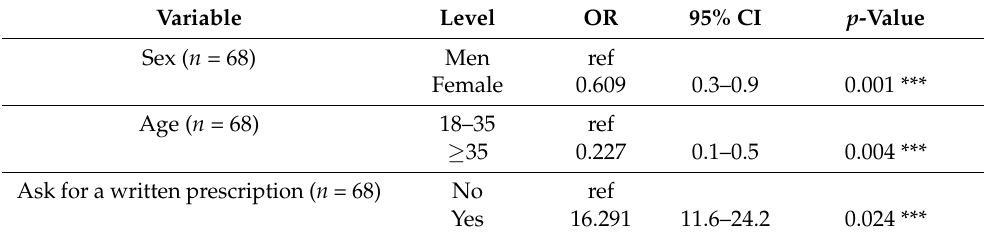
Table 8. Summary of maximum-likelihood estimates for determinants associated with AMR